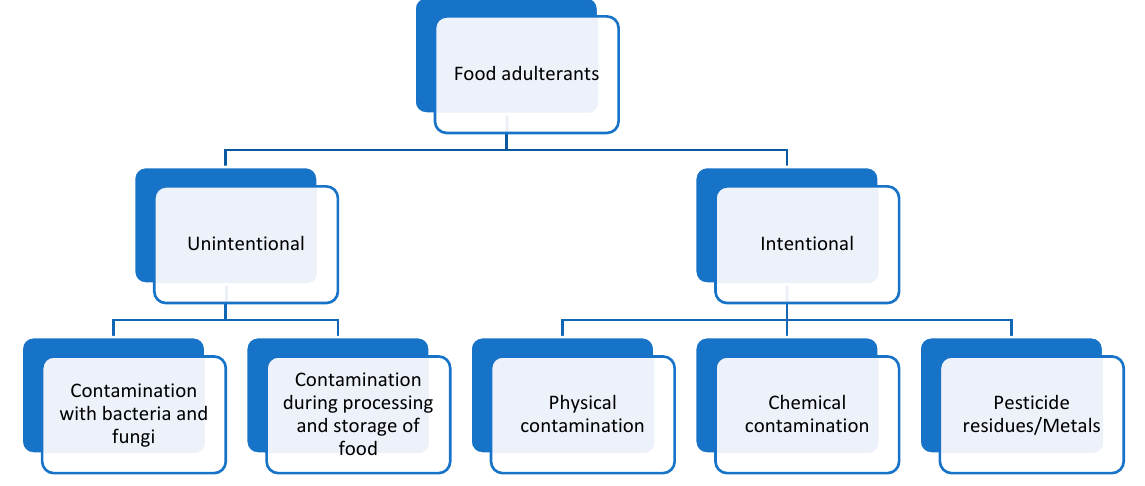
Figure 3. Types of food adulteration.